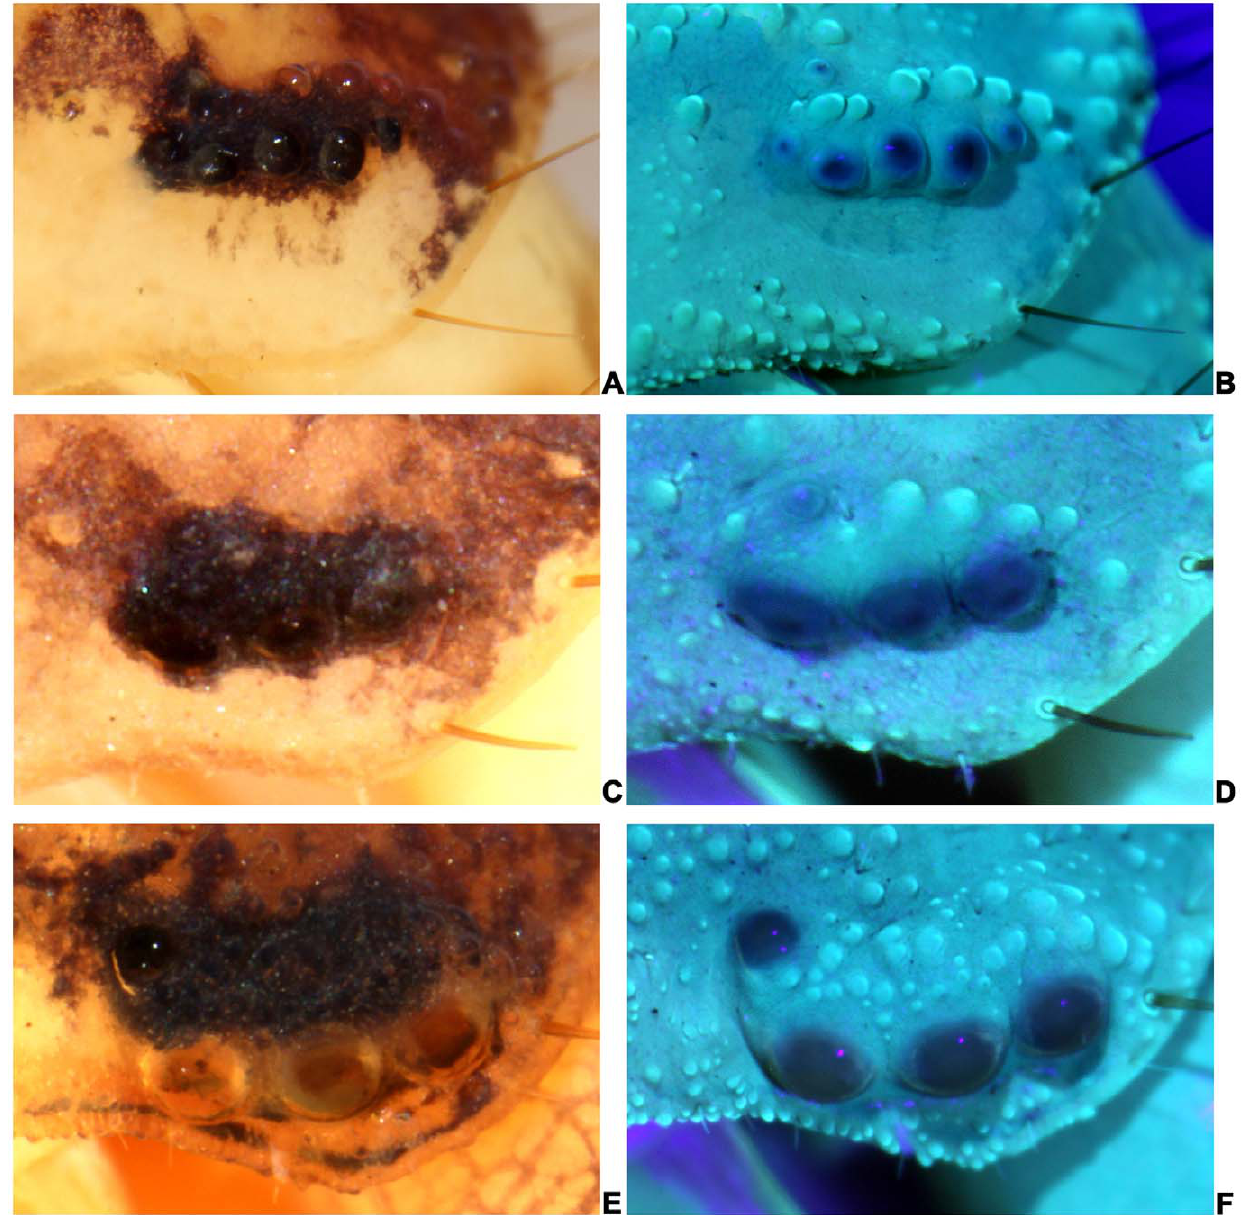
Figure 4. Representive specimens with exceptional number of lateral eyes. (A)&(B) A specimen with 6 lateral eyes, M. caucasicus intermedius , (C)&(D) A specimen lacking No. 4 lateral eye, M. martensii martensii , (E)&(F) A specimen lacking No. 5 lateral eye, L. mucronatus .